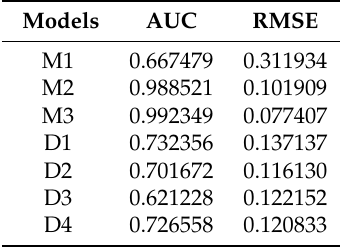
Table 7. Performance for the seven models using the top 10 features from model M3 on the test dataset.